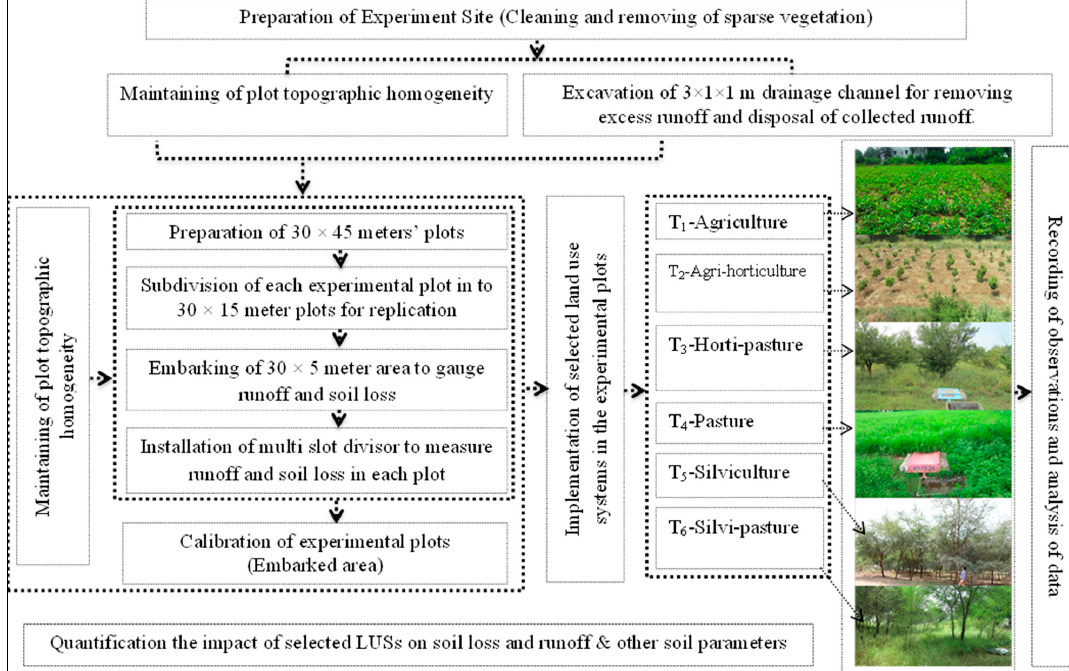
Figure 2. Flow chart of methodology and layout details with field view of one replication under different land use systems .